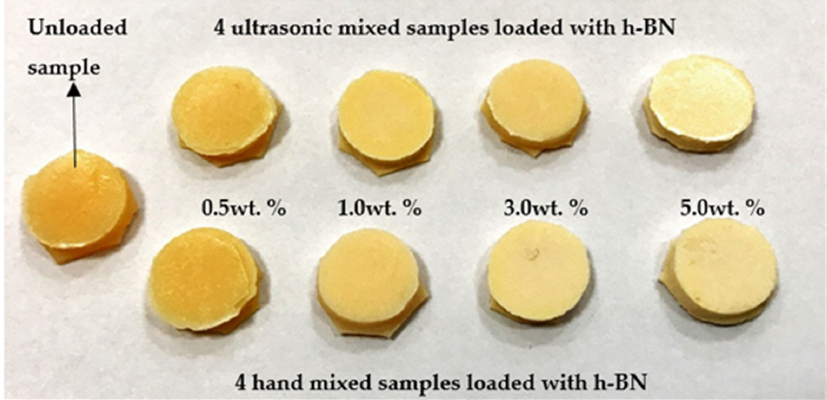
Figure 1. Pictures of a typical control sample and specimens made by mixing nano-sized hexagonal